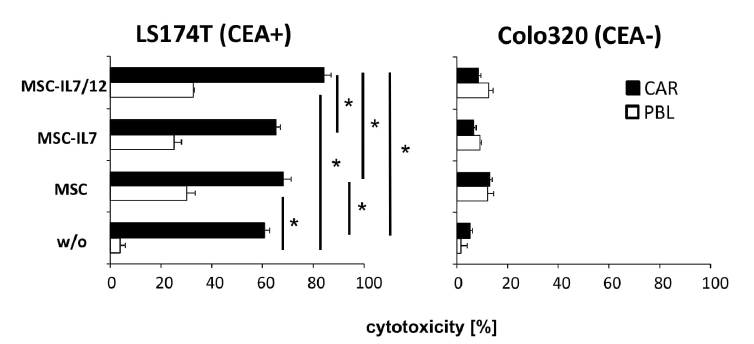
Figure 6. Cytokine engineered MSCs modulate a cytolytic CAR T cell attack. Anti-CEA CAR T cells and non-modified T cells for control (each 1.5 × 10 4 cells / well) were co-cultivated for 48 h with CEA + LS174T or CEA − Colo320 tumor cells (each 2.5 × 10 4 cells / well) and non-modified or IL7 and IL7 / IL12 secreting MSCs (each 3 × 10 3 cells / well) in 96-well round bottom plates. Viability of tumor cells was determined by a tetrazolium salt based XTT-assay. Cytolysis [%] was determined by recording the reduction in viability. Values represent the mean of replicates +/ − standard deviation (SD). Significant di ff erences were calculated by Student’s T test, * p < 0.05. Cells 2020 , 9 , x